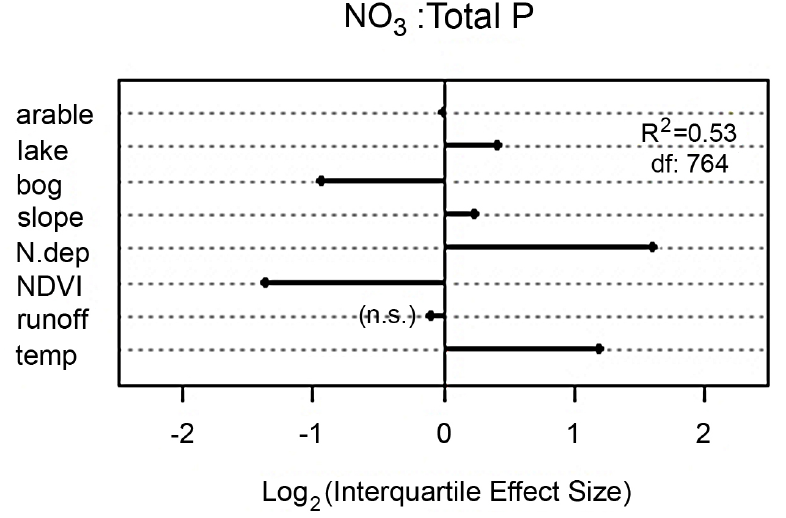
Figure 3. Effect plot of catchment properties; fractions or arable land, lakes, bogs, N-deposition, vegetation cover (inferred from the satellite-derived NDVI-index) terrain slope, mean annual temperature and runoff of NO :TP-ratios in nearly 1000 surveyed 3 lakes. Extensions of lines scaled to the relative positive (to the right of the vertical line) or negative impacts of the included variables. The multivariate model explains 53% of observed NO :TP. See [19] for 3